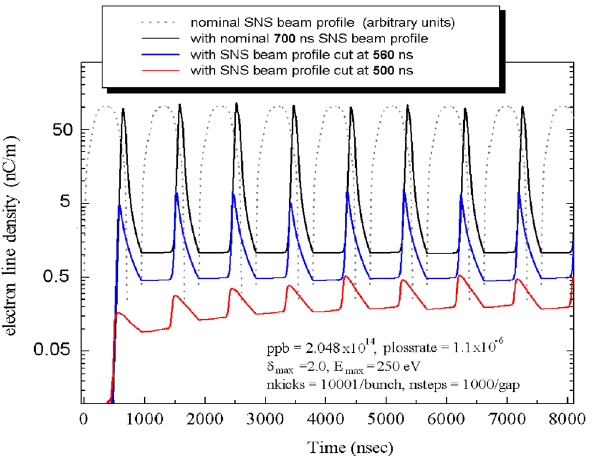
FIG. 15. (Color) Simulated electron density in an SNS field- (cid:3) 2 and N (cid:3) 2 : 05 (cid:11) 10 14 . We free region, assuming (cid:3) p max have artificially truncated the tail of the bunch, while main- taining the same integrated beam charge. The density of the electron cloud decreases as the tail of the beam is progressively